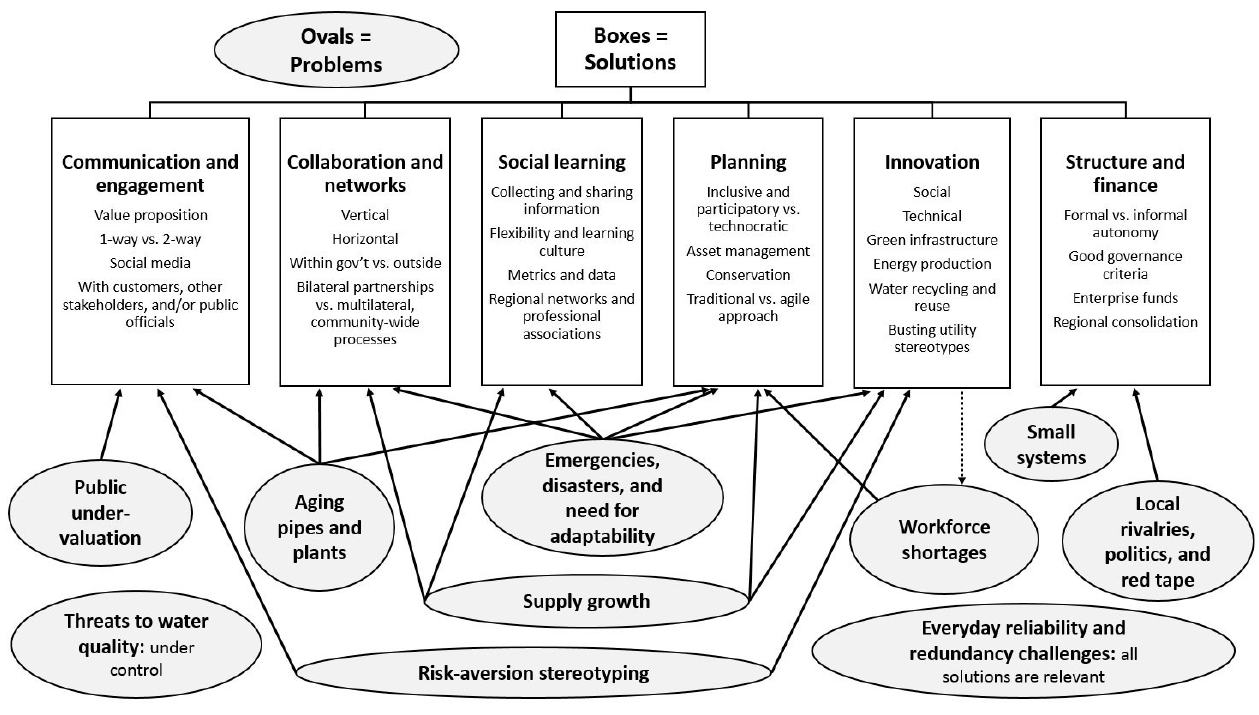
Fig. 1 . Level 2 axial codes derived from interview and focus group